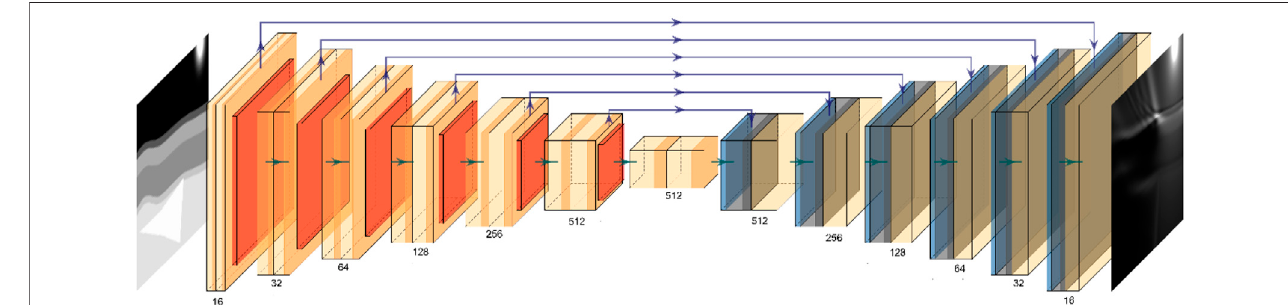
FIGURE 3 | Constructed UNet network with 6 downsampling layers.